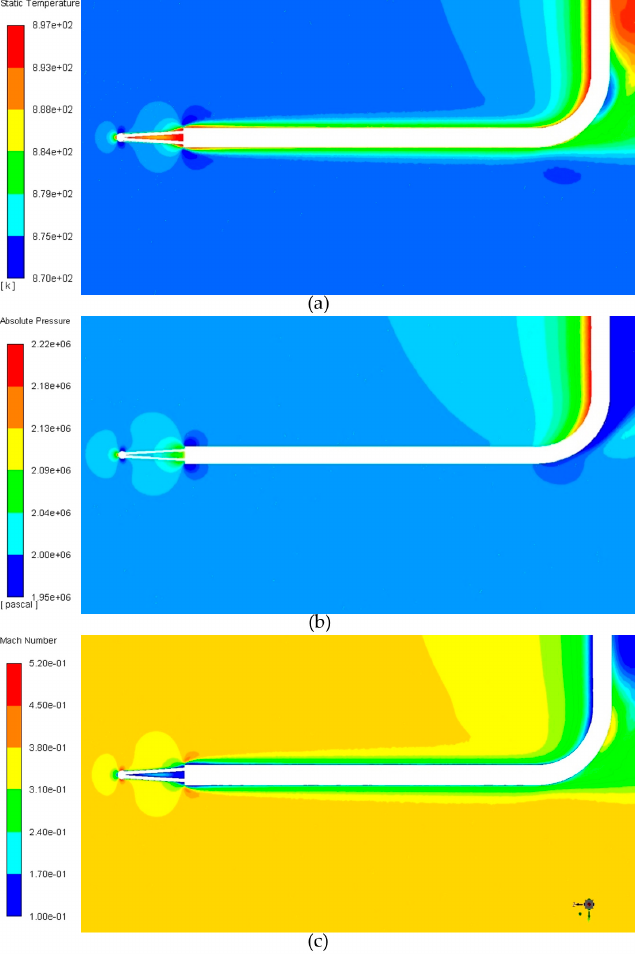
Figure 5. Contour plots of ( a ) static temperature, ( b ) pressure, and ( c ) velocity distributions for the no-screen thermocouple (NST).